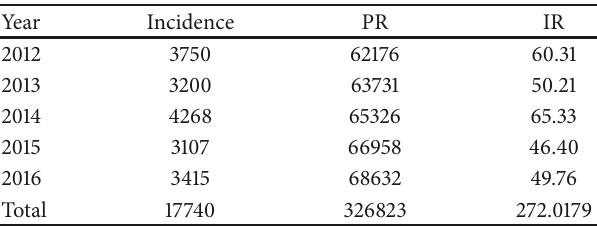
Table 2: Diarrhea annual incidence rate in Jasikan District from 2012 to 2016.